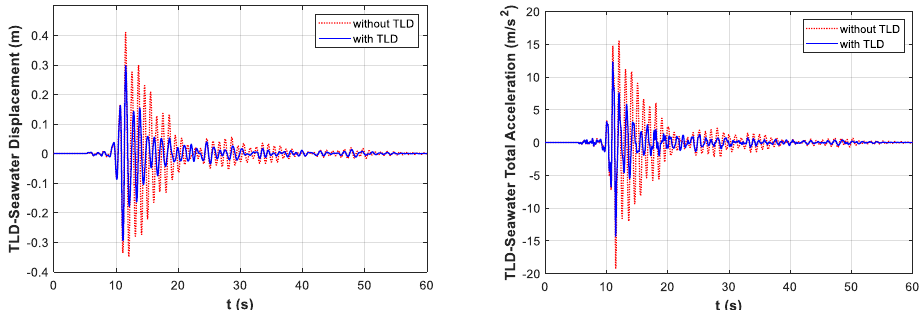
Figure 10. AHS optimization of the 10-story structure displacement – time and total acceleration – time graphs in the DUZCE/BOL090 earthquake record for TLD – propanol.